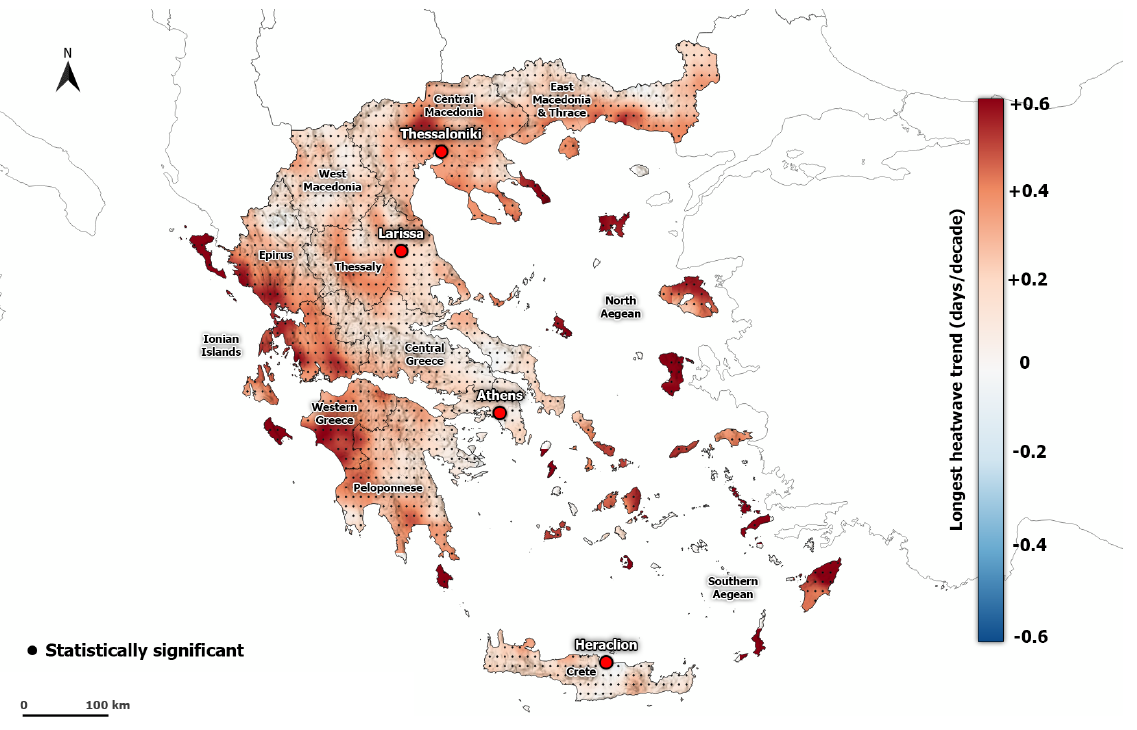
Figure 8. Spatial distribution of summer HWD trend (days per decade) calculated from ERA5-Land during the period 1950–2020. Dots indicate significant trends at the 95% level.